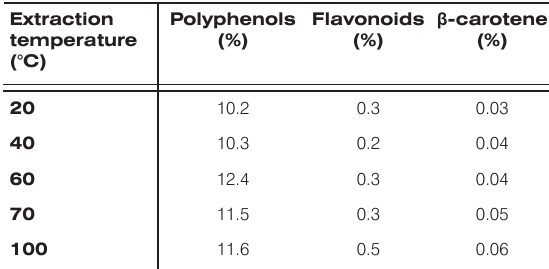
Table 2. Content of target compounds in the dried extract (water